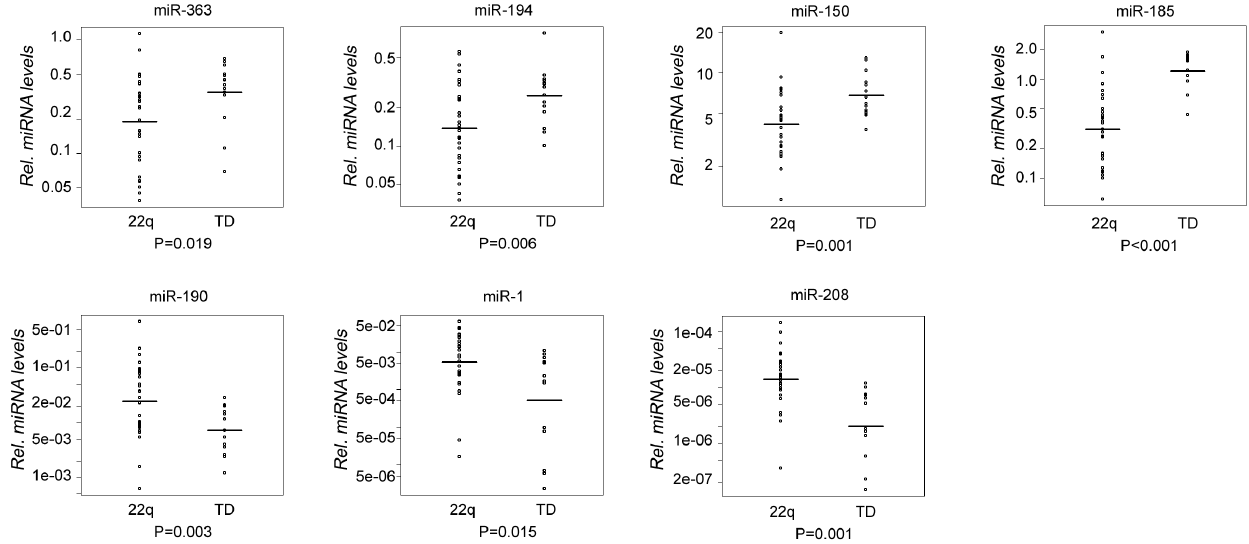
Figure 4. Altered miRNA expression in 22q11DS. Relative miRNA levels are shown for 7 miRNAs that demonstrated differential expression levels when comparing 30 individuals with 22q11DS and 15 TD individuals. miRNA levels were normalized to the reference U6 snRNA. Circles represent observed data. Horizontal lines represent geometric means. Respective p-values are shown.